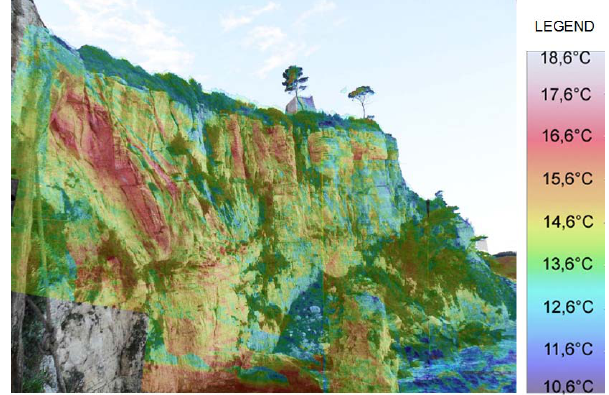
Fig. 10. Thermal static map obtained by IRT remote surveys of the overall Mt. Pucci cliff